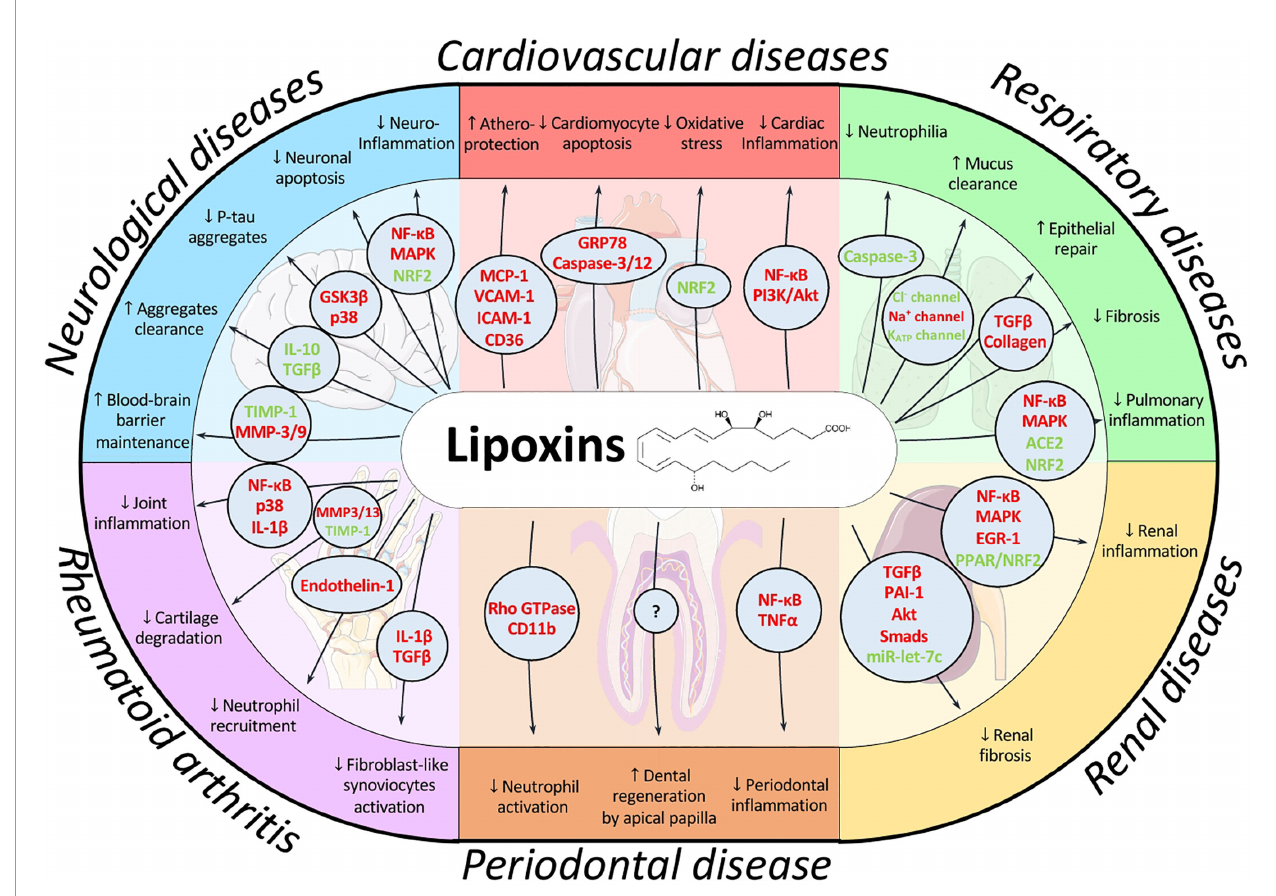
FIGURE 3 | Schematic overview of the main signaling pathways modulated by lipoxins and their effects in the pathologies addressed in this review. LXs have been described to coordinate a wide range of signaling pathways depending on cell context, allowing for a fi ne-tune regulation of the resolution process. For example, they induce apoptosis in neutrophils to promote their clearance while they prevent apoptosis in cardiomyocytes thus exhibiting cardioprotective actions. By modulating different pathways, LXs can exert protective effects on different cell types and environments, as observed by their effects on the brain, heart, lung, liver, periodontium and joints. Mediators highlighted in red indicate downregulation or inhibition by LX action whereas green indicates upregulation or